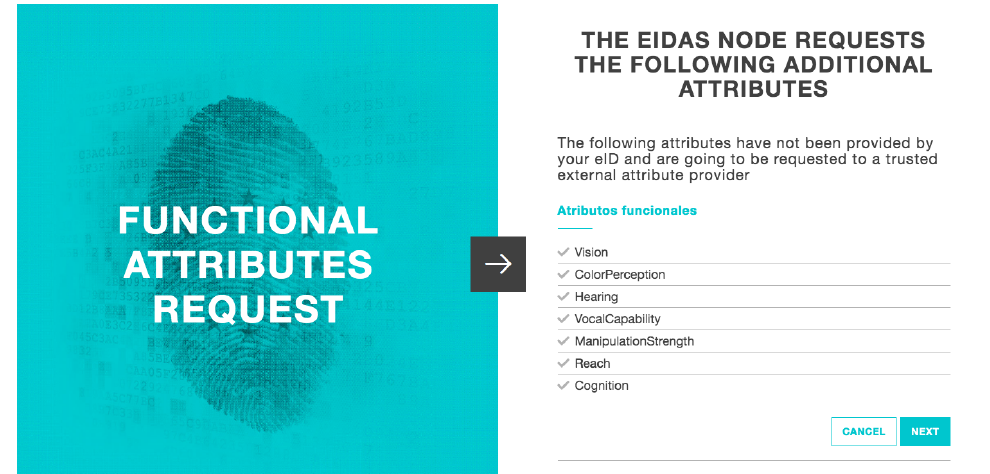
Figure 8. eIDAS node functional attributes request.